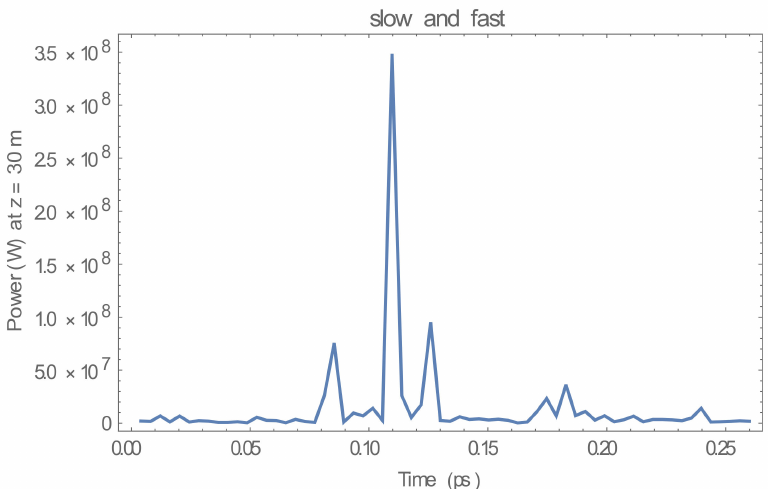
Figure 11. The temporal pulse shape at z = 30.0 m for the sum of the fundamental and the higher- order modes of h = 1, 3, and 5 modes in the two-beam system with the elliptically polarized undulator (color online).